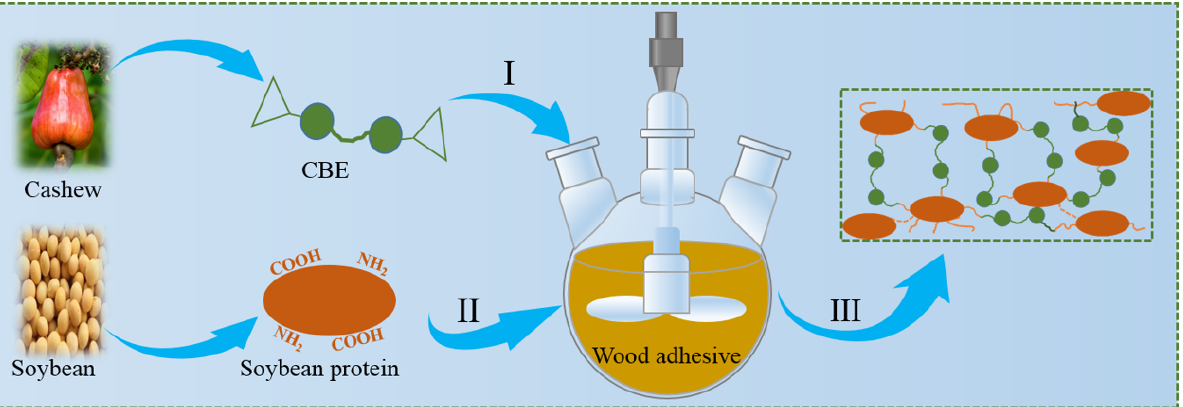
Figure 1. Schematic illustration of preparation soybean protein ‐ based adhesive and its curing . （ I: Ultrasonic dispersion: II: Add soybean protein and adjust pH; III: Hot ‐ press curing ）